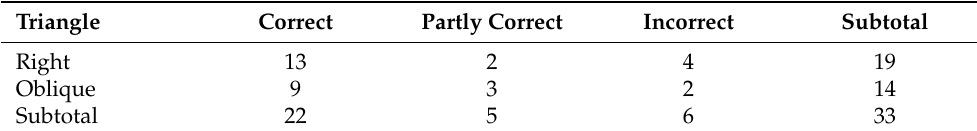
Table 13. Frequencies of student’s results by using different strategies.